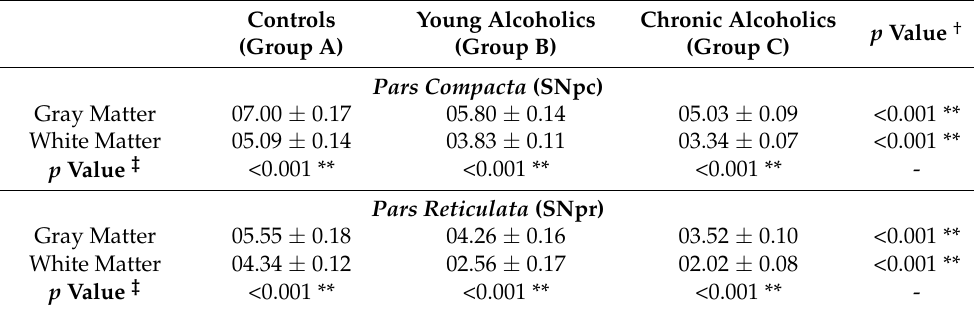
Table 2. Distribution of CD31+ vessels per visual field in different regions of SN.